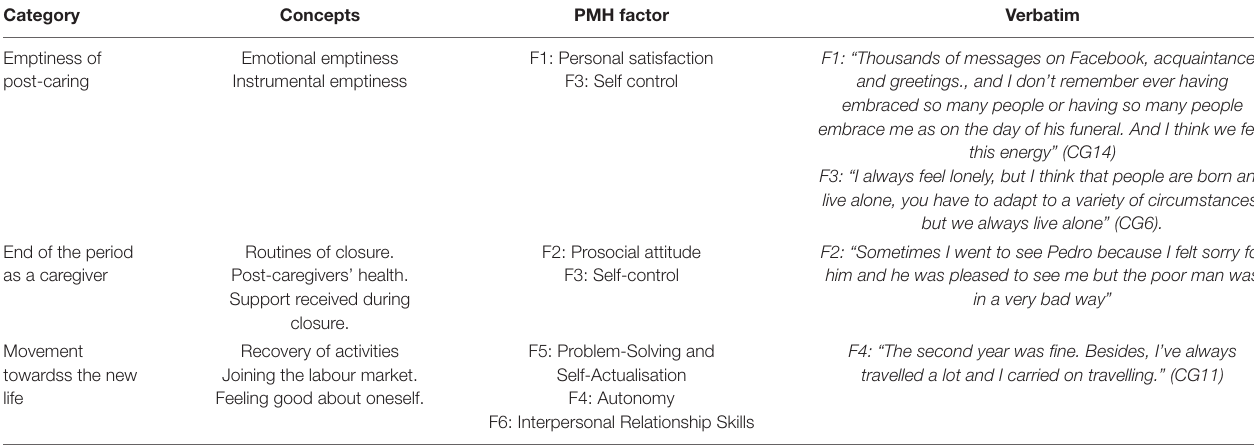
TABLE 2 | Relationship established between categories and PMH factors (Lluch, 1999). Category Concepts PMH factor Verbatim Emptiness of Emotional emptiness post-caring Instrumental